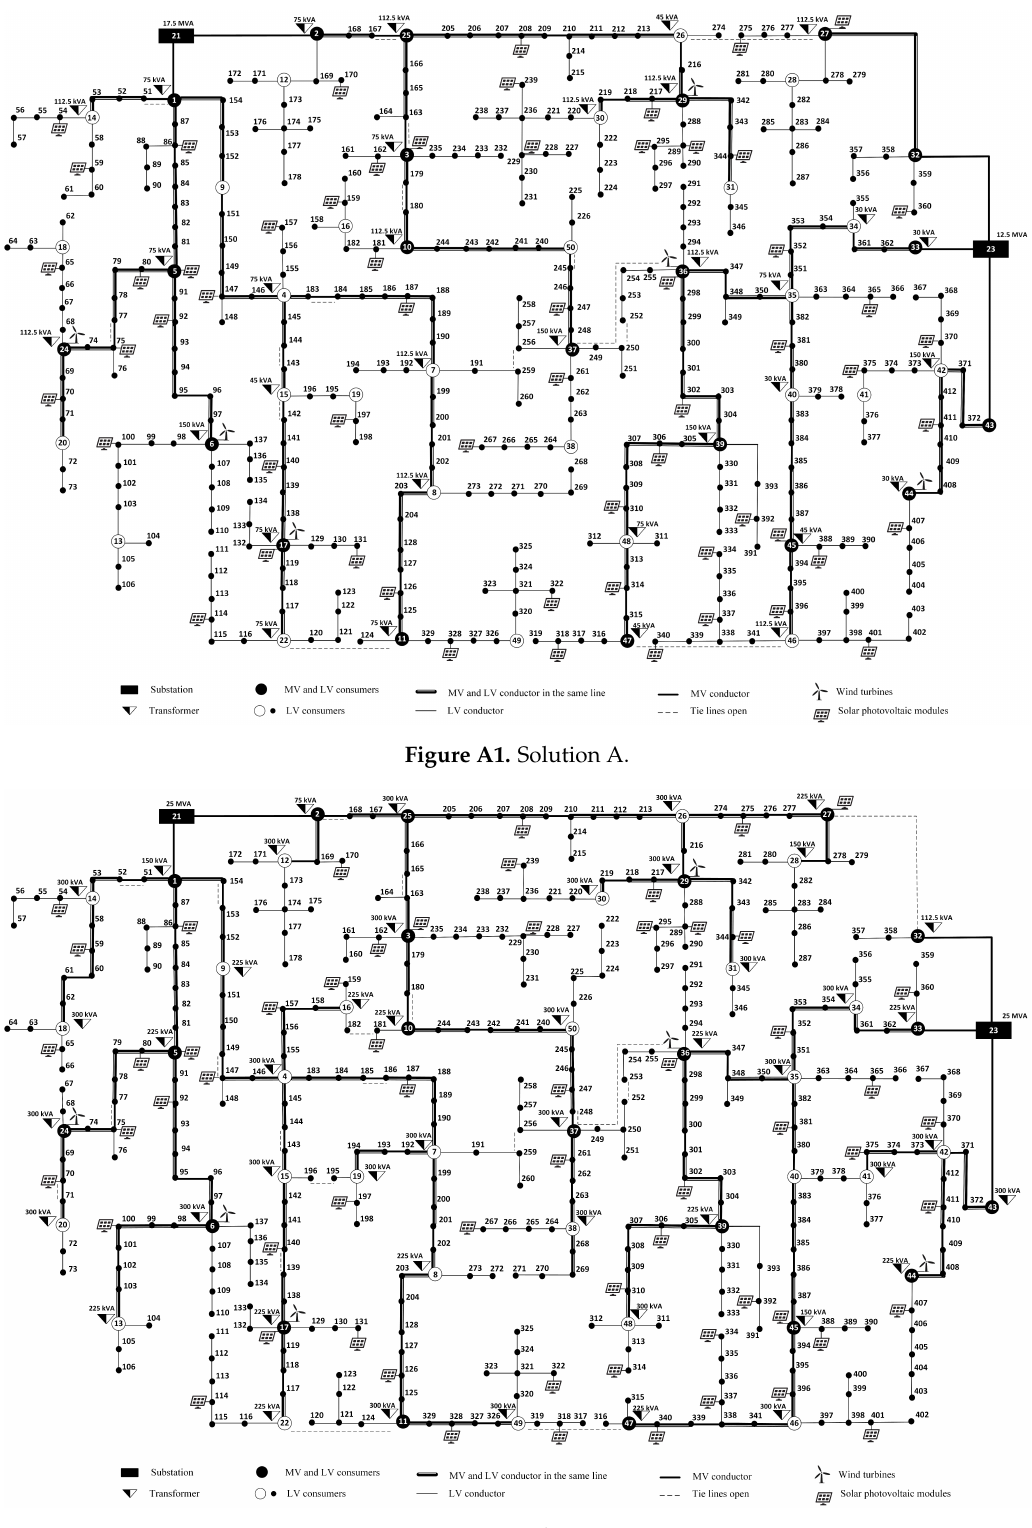
Figure A2. Solution